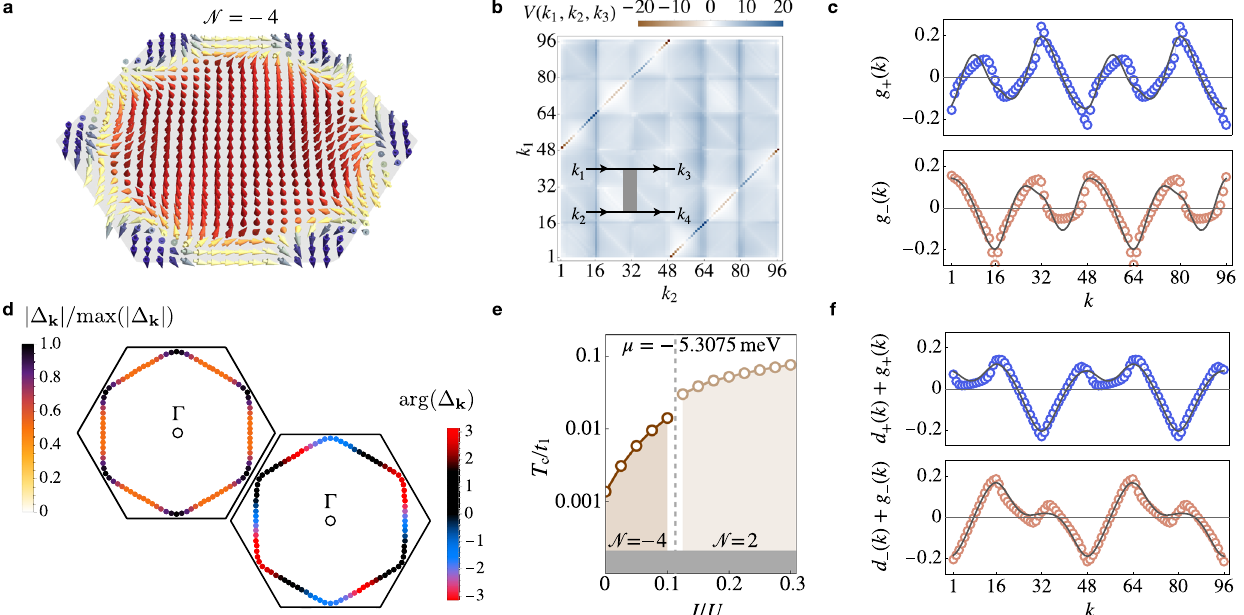
Fig. 2 Topological superconductivity in hetero-bilayer TMDs. a The phase winding of the superconducting gap in the g + i g state can be þ j Δ j 2 Þ 1 = 2 . m points up (down) at the highest visualized by a skyrmion con fi guration constructed from the vector m ¼ ð Re Δ k ; Im Δ k ; ξ k Þ = ð ξ 2 k k (lowest) energies ξ k = ϵ k − μ and rotates N times in the plane in the vicinity of the Fermi level ξ k = 0. The skyrmion con fi guration is used to calculate the winding number N , which for a broad range of fi llings around Van Hove fi lling is jNj ¼ 4 , indicating an enhanced response in thermal and spin quantum Hall measurements. b Functional RG data of the irreducible two-particle correlation function V ( k 1 , k 2 , k 3 , k 4 ) near the instability temperature for incoming wave vectors k 1 , k 2 . Wave vectors are labeled by the patch points along the Fermi surface indicated in Fig. 1c. The outgoing wave vector k 3 is fi xed at patch no. 1 and k 4 = k 1 + k 2 − k 3 is given by momentum conservation. The sharp diagonal features occur at k 1 = − k 2 , k 3 = − k 4 , indicating the formation of long-ranged superconducting correlations. c Superconducting form factors g ± ( k ) extracted from V ( k 1 , k 2 , k 3 , k 4 ) in b. They exhibit a large overlap with a linear combination of the second-nearest-neighbor lattice harmonics g 1 ( k ), g 2 ( k ) (solid gray lines) de fi ned in the text, which belong to the two-dimensional irreducible representation E 2 of the lattice symmetry group C 6 v . We classify them as g -wave form factors due to their eight nodes. d Absolute value and phase of the gap function on the Fermi surface. The chiral superposition Δ k = ∣ Δ ∣ ( g 1 ( k ) ± i g 2 ( k )) fully gaps the Fermi surface, thereby minimizing the energy. Such a g + i g superconducting state breaks time-reversal symmetry and is topological with a four-fold phase winding along the Fermi surface jNj ¼ 4 . e Stability of the g -wave superconduting state towards inclusion of J / U for V 1 / U = 0.2 at μ = 5.3075 meV. For growing values of the exchange interaction J , the nearest-neighbor harmonics d 1 and d 2 of E 2 (de fi ned in the text) start to contribute as indicated by the colored transition. They are pure d -wave form factors with only four nodes. For J / U ≲ 0.1, the contribution from d 1 and d 2 is negligible. f Example of the extracted form factors for J / U = 0.5 where d 1 , d 2 and g 1 , g 2 roughly contribute by equal amounts, showing the change in the number of nodes due to the harmonics. Within an irreducible representation, lattice harmonics Closest to Van Hove fi lling μ ≈ − 5.5 meV, we fi nd that correlations with the same symmetry but different angular-momentum form corresponding to a valley density wave (VDW) are strongest, which factors can mix and it depends on microscopic details which manifest themselves by peaks at the nesting momenta Q α , α = 1, 2, 3 in V ( k − k = Q − k = Q lattice harmonics are the strongest. The valley symmetry α or k 3 α . 1 , k 2 , k 3 , k 4 ), i.e. at k 3 1 2 follows from the properties of the lattice harmonics under This state is the analogue of a spin density wave 50,51 considering inversion: even (odd) lattice harmonics correspond to valley that, here, the SU(2) symmetry belongs to a pseudo-spin formed singlet (triplet) pairing. We obtain two valley-singlet pairing by the valleys. The VDW instability is insensitive towards the regimes with different spatial symmetries depending on V n . For inclusion of V n in the explored range. Moving the fi lling slightly away from Van Hove fi lling, we obtain small V n , we fi nd a small regime with A 2 symmetry ( i -wave) in a superconducting instability, which is indicated by diagonal peak agreement with previous results for V n = 0 52,53 . However, for larger positions, i.e. V ( k 1 , k 2 , k 3 , k 4 ) ≈ V ( k 1 , − k 1 , k 3 , − k 3 ), that correspond V n ( V 1 / U ≳ 0.15), including realistic values in twisted TMDs 34,39 , we to electron pairs with a total momentum of zero k 1 + k 2 = k 3 + unveil a large regime with E 2 symmetry, which contains both, d - k and g -wave form factors. The pair correlations in this regime are fi tted well using the second-nearest-neighbor lattice harmonics